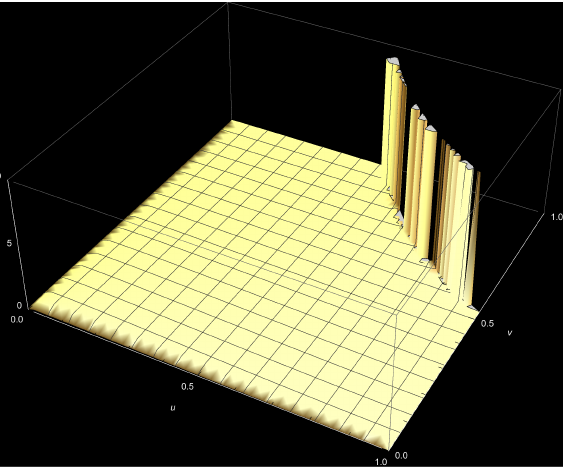
Figure A16. The bivariate Kumaraswamy contour (Equation (1)) plot, where α = 1.1, β = 1.1, θ = 0.8 and δ = 2.